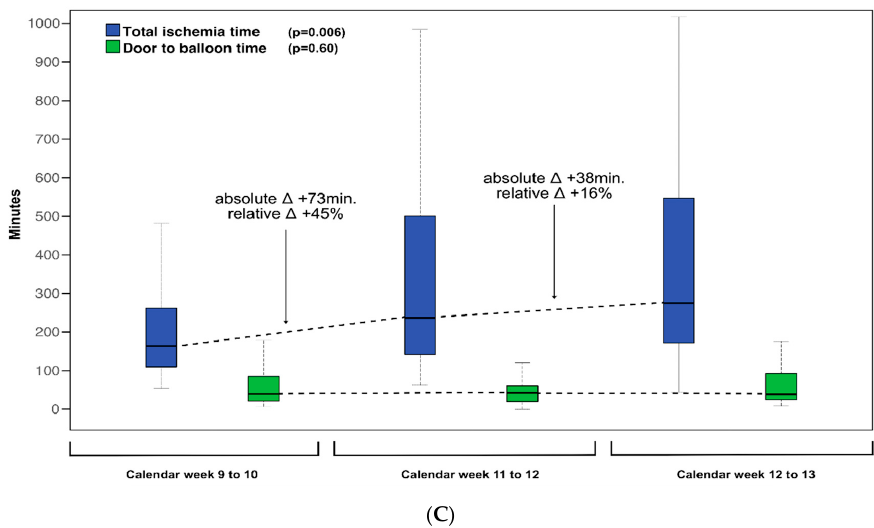
Figure 2. COVID-19 hospital admissions for STEMI and treatment delays. ( A ) Official statistics of all documented laboratory-confirmed cases of COVID-19 in Austria during the study period; ( B ) number of STEMI admissions compared between calendar week 9 and 10 (group 1), calendar week 11 and 12 (group 2), and calendar week 13 and 14 (group 3); ( C ) total ischemic time and door-to-balloon time of STEMI patients treated in calendar week 9 and 10 (group 1), calendar week 11 and 12 (group 2), and calendar week 13 and 14 (group 3). Abbreviations: STEMI = ST-elevation myocardial infarction; COVID-19 = coronavirus disease 2019.